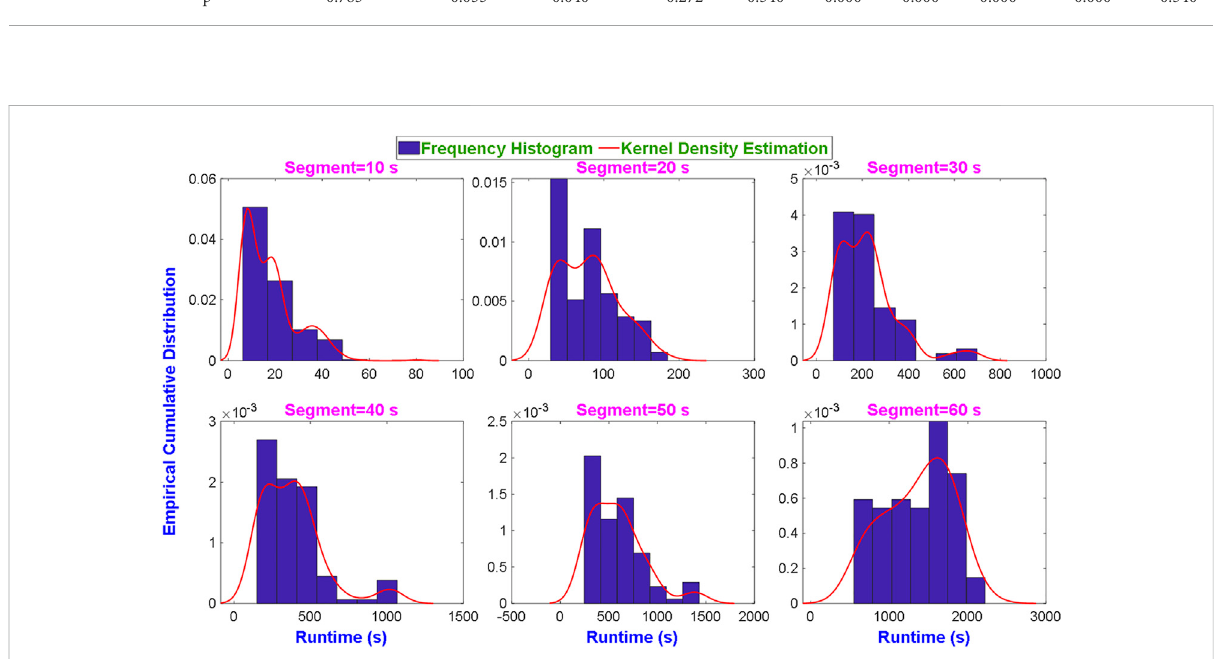
FIGURE 5 The running times of VG feature extraction under different data